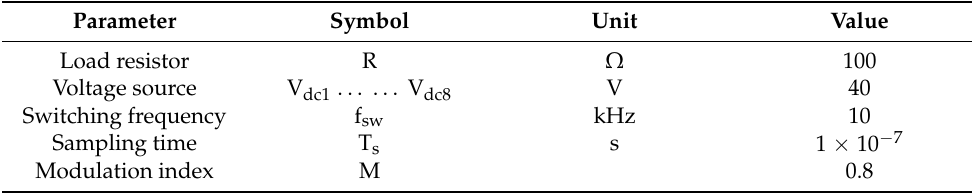
Table 4. Parameters of five-level DC/AC converter.